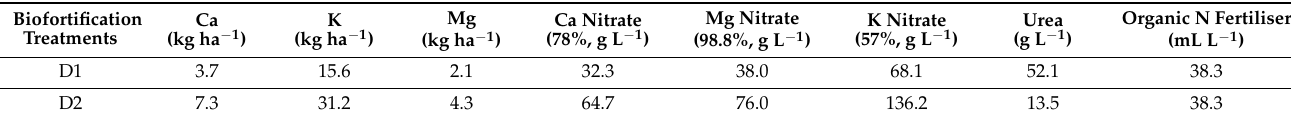
Table 1. Quantitative mineral cations per hectare (kg ha − 1 ) and dosages of Ca, Mg, K, urea (g L − 1 ), and organic nitrogen (mL L − 1 ) applied in D1 or D2 treatments, considering 600 L ha − 1 as irrigation volume. Percentage in brackets indicates salts purity.